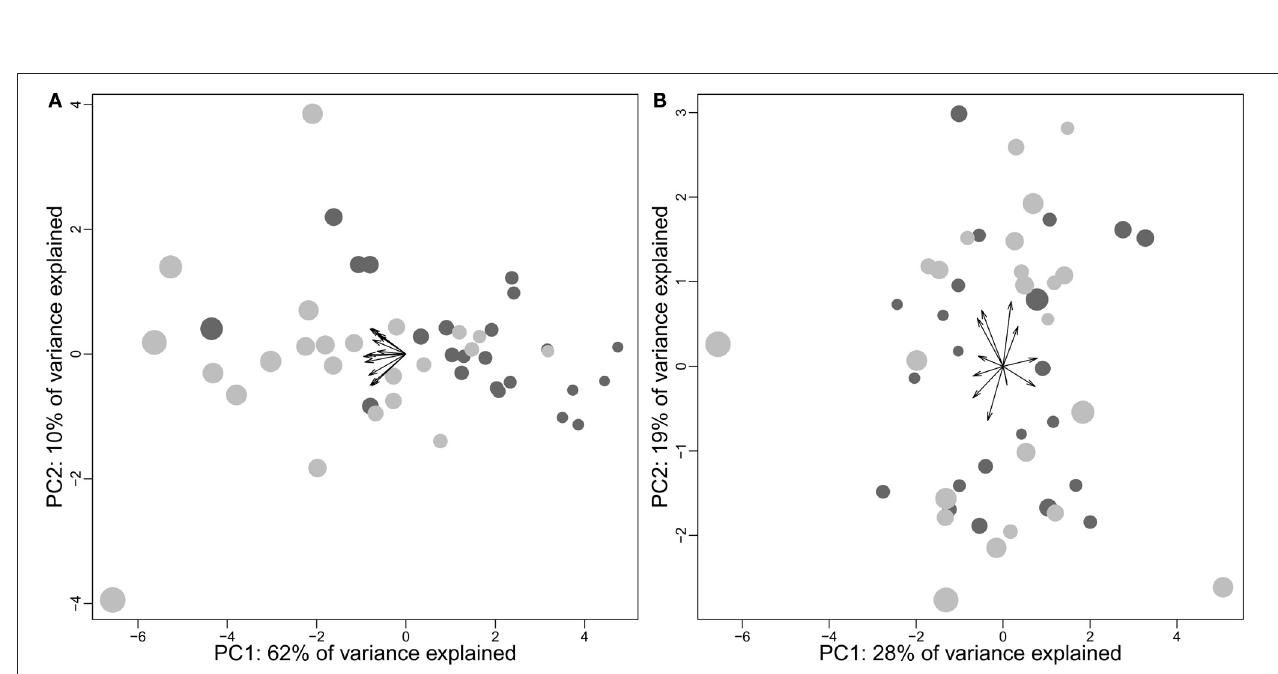
(human species excluded). (B) Density plot based on the position on the precedent first component of 5000 simulated brains constructed by taking 5000 random values for every structure with a normal distribution and a mean and standard deviation similar to the real dataset. The dashed line indicates the regression slope for simian brain size as a function of species position on the principal component analysis.